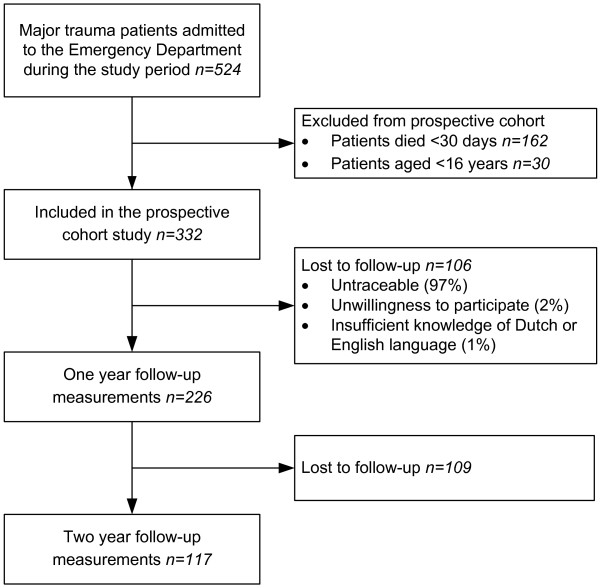
Flow chart of the patient inclusion throughout the study.